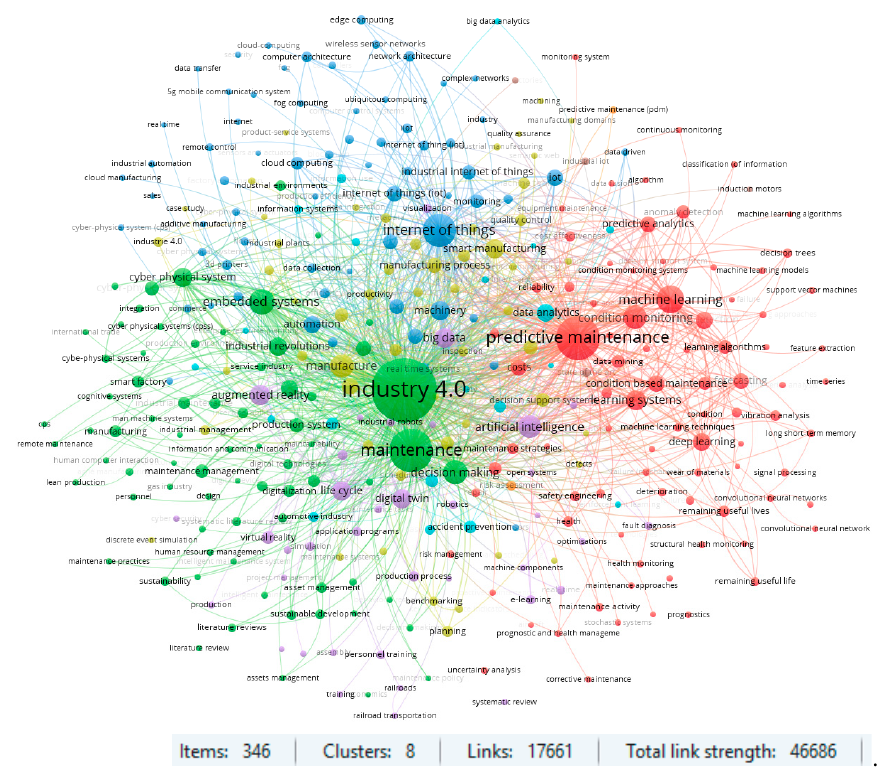
Figure 15. Analysis of keyword strength for the third cluster of publications from the WoS database. Source: own development using VOSviewer software [101].